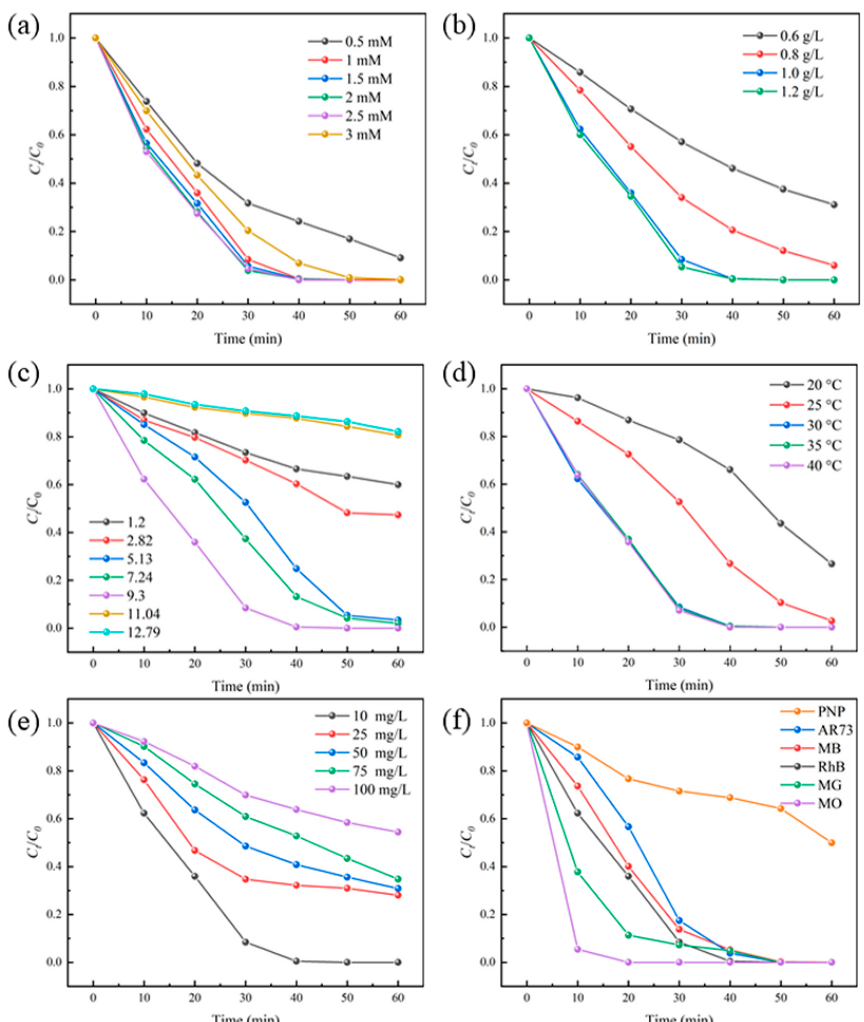
Figure 5. Effects of PMS dosages ( a ), catalyst dosages ( b ), initial pH values ( c ), reaction temperatures ( d ) and initial RhB concentrations ( e ) on the RhB degradation in the 850CC/PMS system, degradation effect of various dyes and PNP by 850CC/PMS ( f ). Control conditions: (RhB) = 10 mg/L, (850CC) = 1.0 g/L, (PMS) = 1.0 mM, temperature = 30 °C, (AR73) = (MB) = (MG) = (MO) = (PNP) = 10 mg/L.